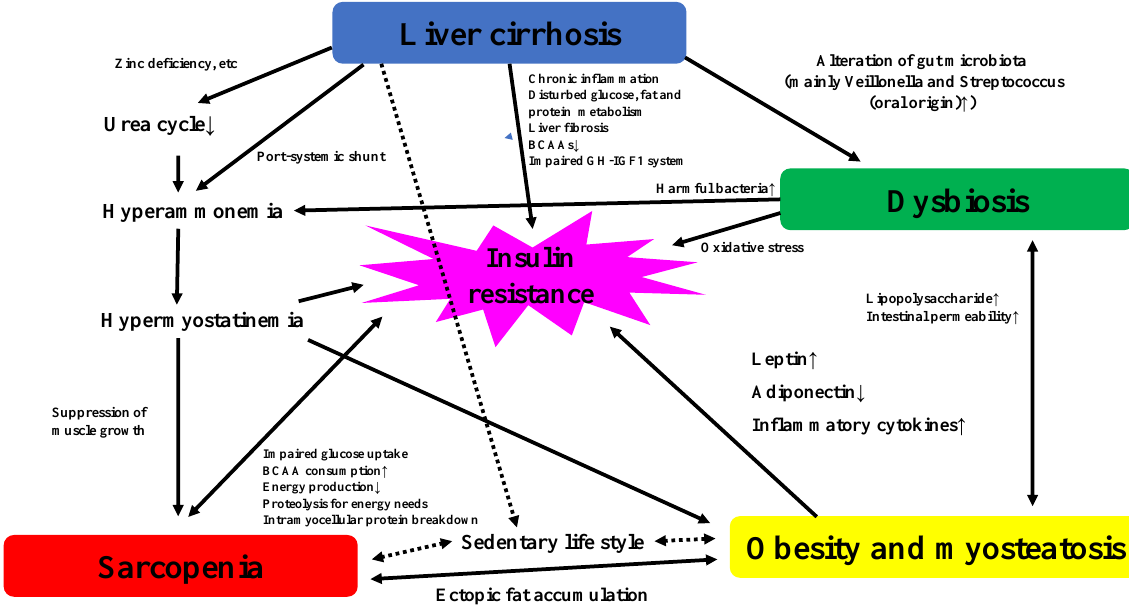
Figure 1. The potential interplay among patients with sarcopenia, liver cirrhosis, obesity, myosteatosis, and dysbiosis. BCAA, branched-chain amino acid; GH, growth hormone; IGF-1, insulin-like growth